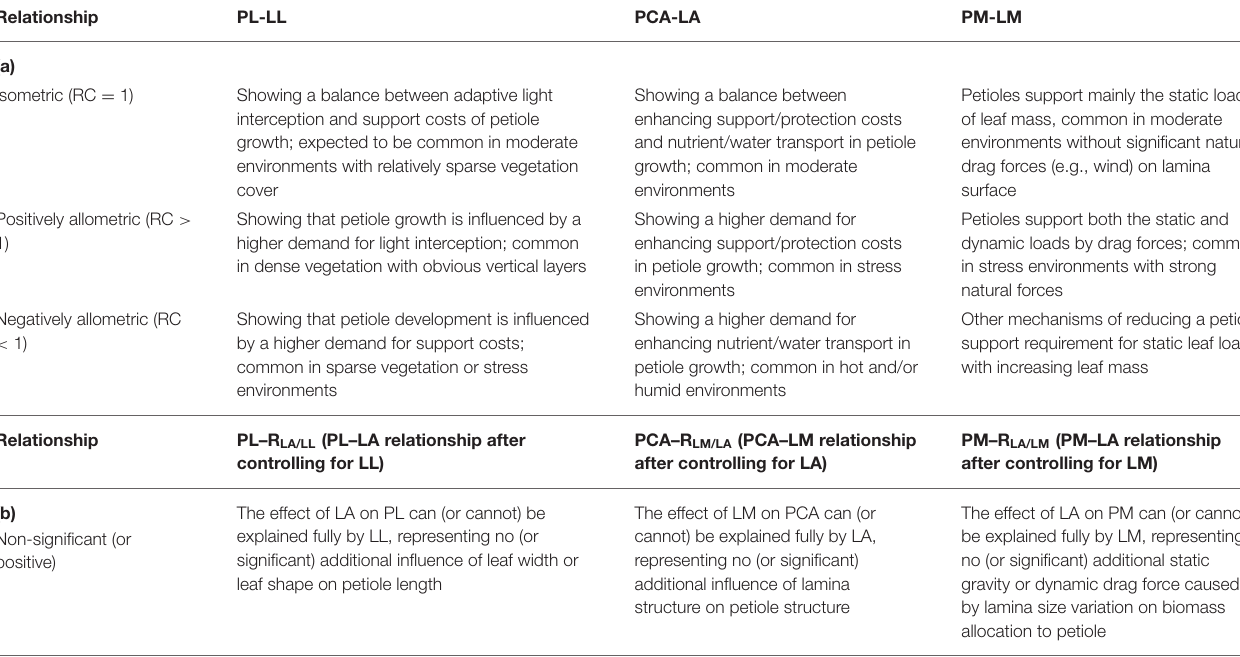
TABLE 1 | The main topics and hypotheses dealt with in this study. Relationship